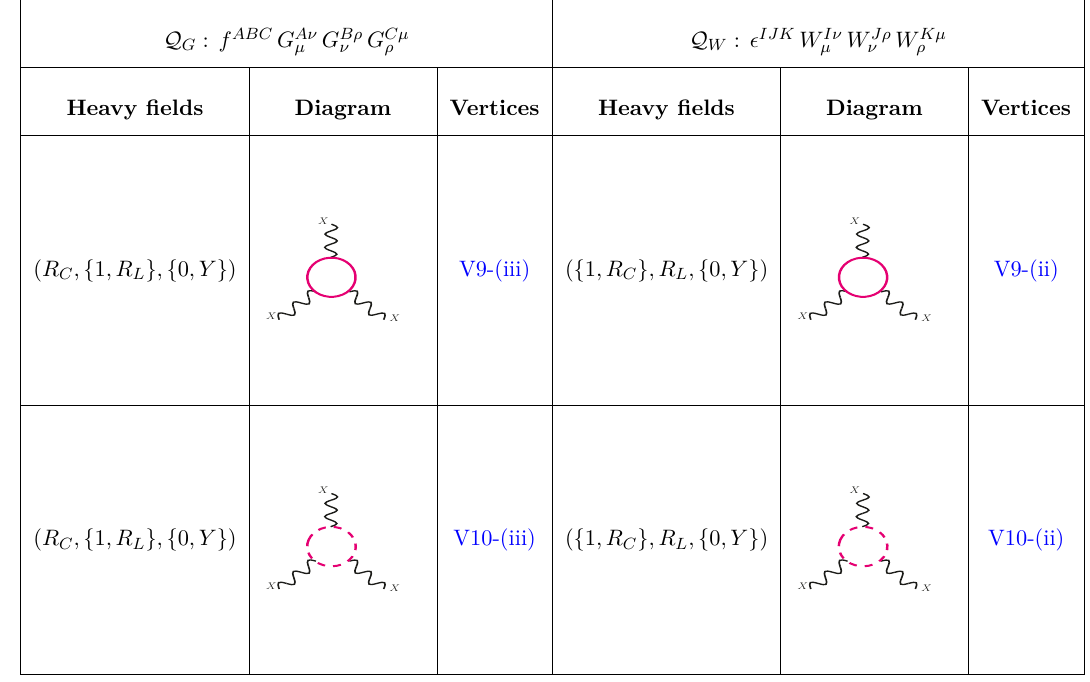
Table 20 . Heavy field representations that are obtained by unfolding the X 3 operators into non- trivial one-loop-level diagrams and the corresponding vertices. A side by side comparison shows the subtle yet significant difference between the heavy field representations enveloped in these